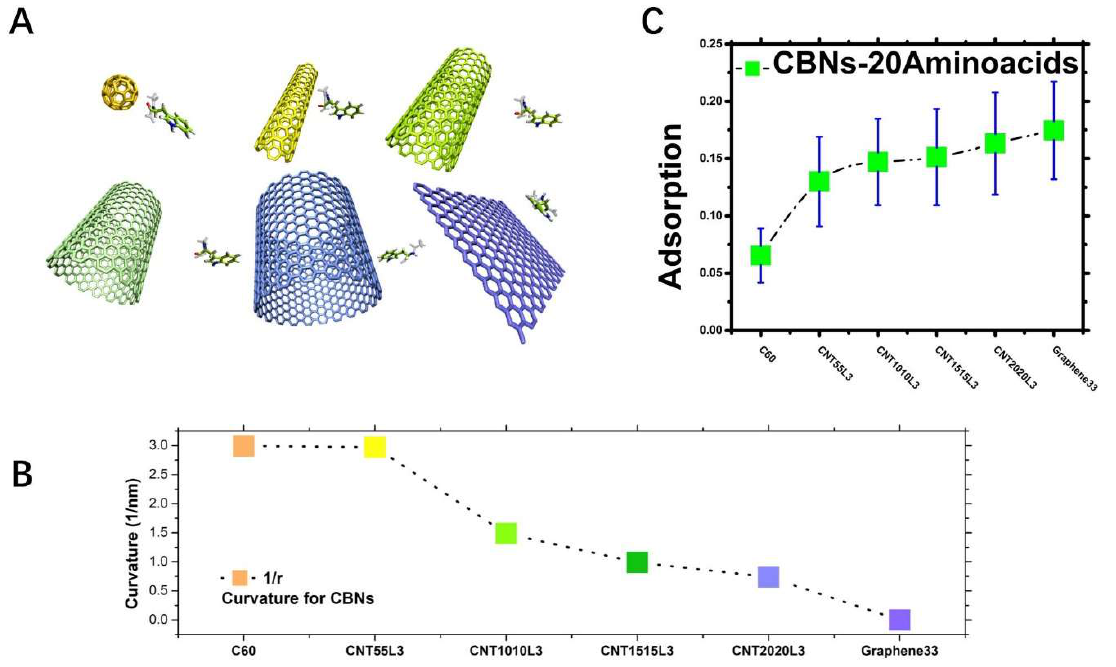
Figure 1. ( A ). Six representative carbon-based nanoparticles; ( B ). The curvatures of six representative CBNs; ( C ). The average adsorption strength of six CBNs for 20 amino acids. The green square is the average adsorption strength of each carbon-based nanoparticle for 20 amino acids, and the blue bar line is the corresponding error.